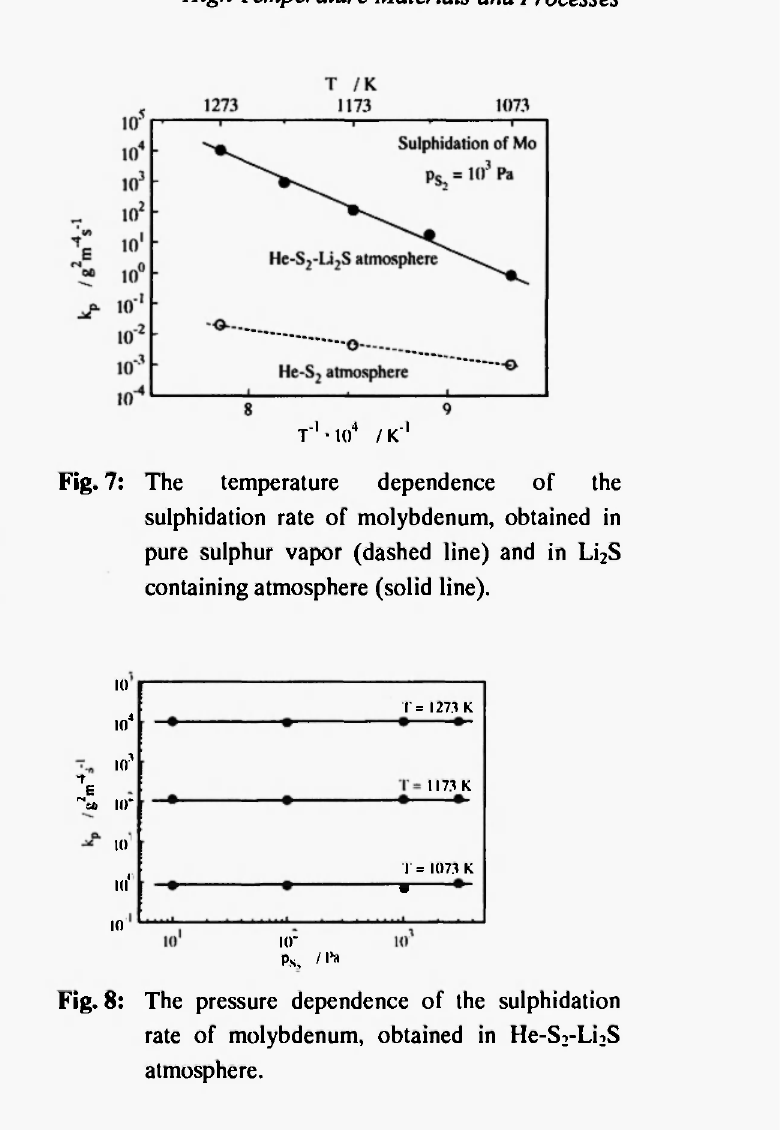
Fig. 8: The pressure dependence of the sulphidation rate of molybdenum, obtained in He-S 2 -Li 2 S